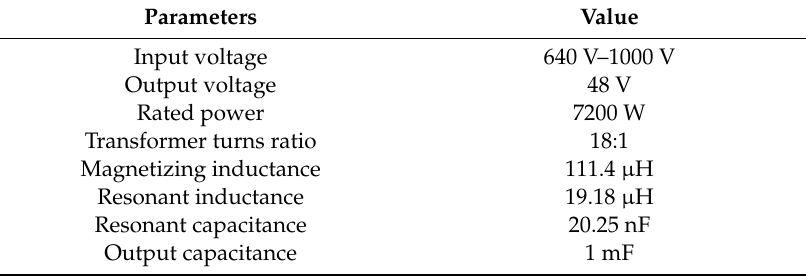
Table 1. The parameters of LLC